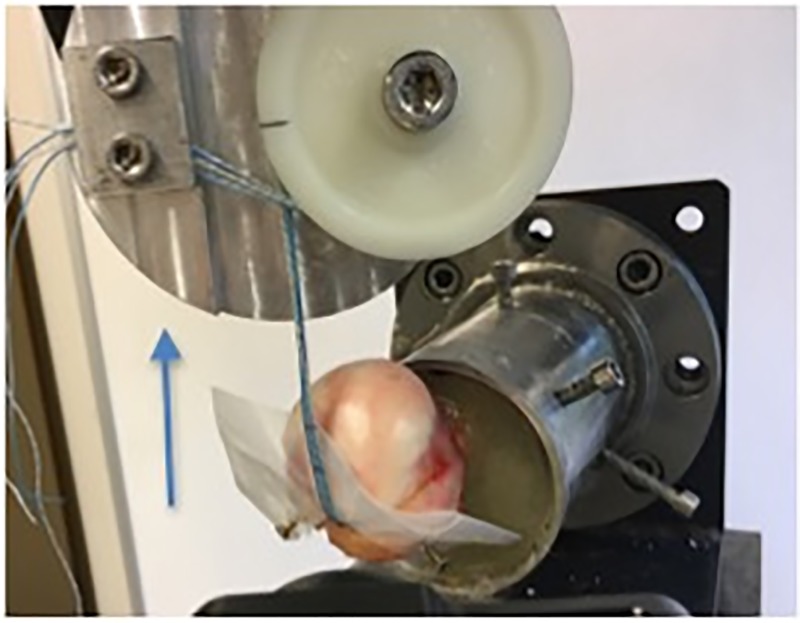
Experimental set up.The blue arrow represents the direction of load application.